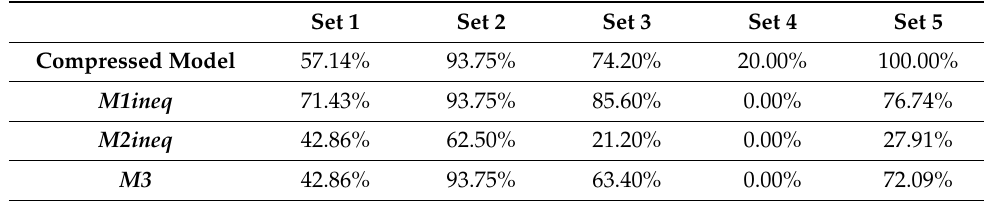
Table 6. Percentage of solved instances.